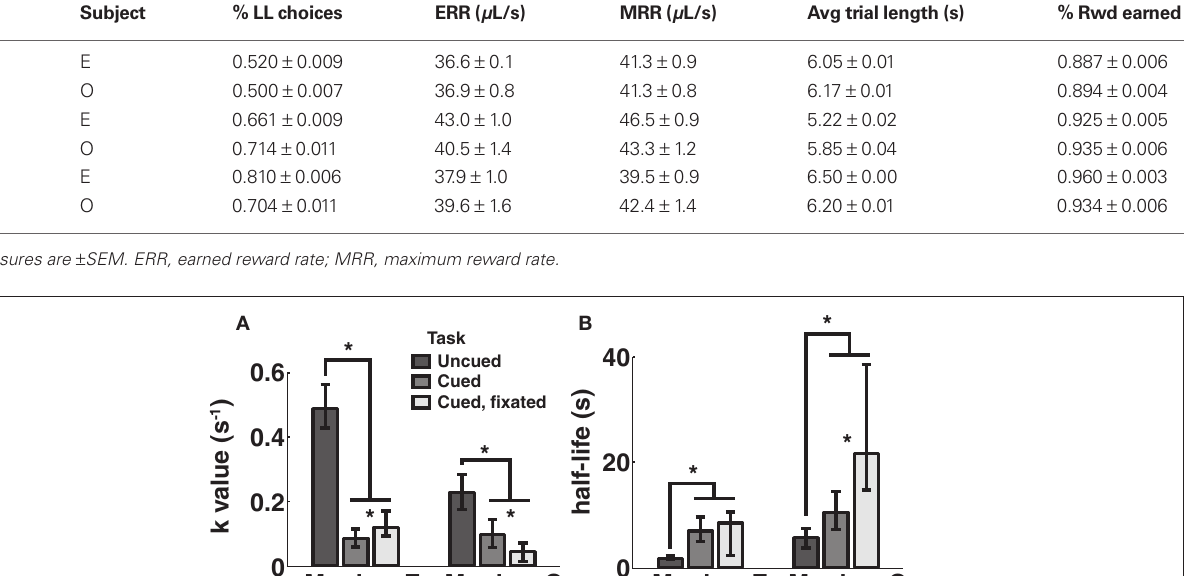
Table 1 | Percentage of LL choices, average trial lengths, and earned and maximum reward rates as a function of task condition. Task